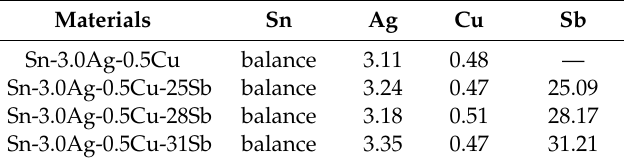
Table 1. Composition of solder alloy